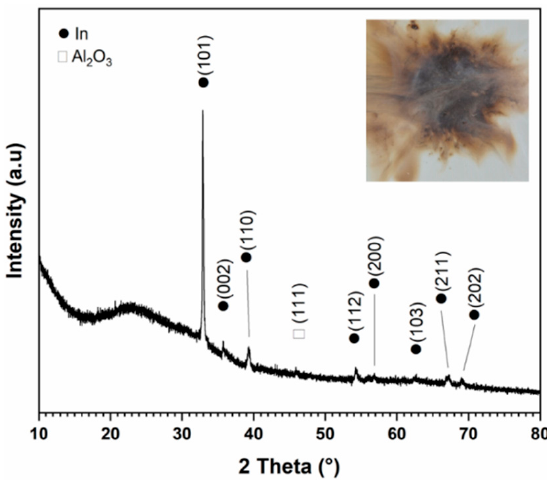
Figure 3. XRD pattern and photograph (insert) of the combustion products of the Al/In 2 O 3 _nm energetic composite material.